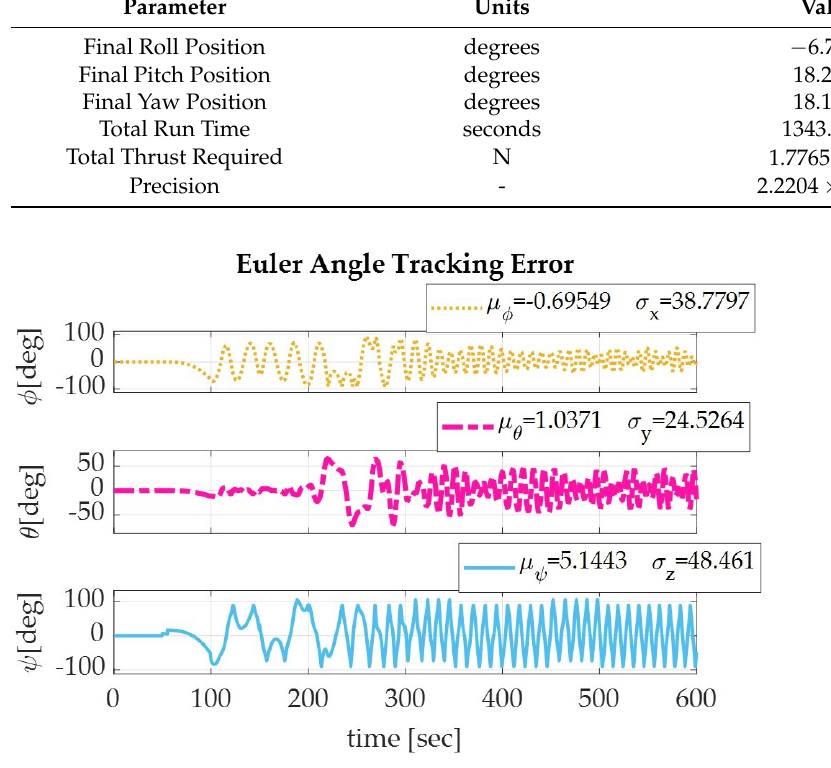
Figure 6. The Euler angle tracking errors for a spacecraft de-orbiting from LEO altitude (1000 km) using the Pontryagin’s autonomous trajectory for roll (yellow), pitch (pink), and yaw (blue).